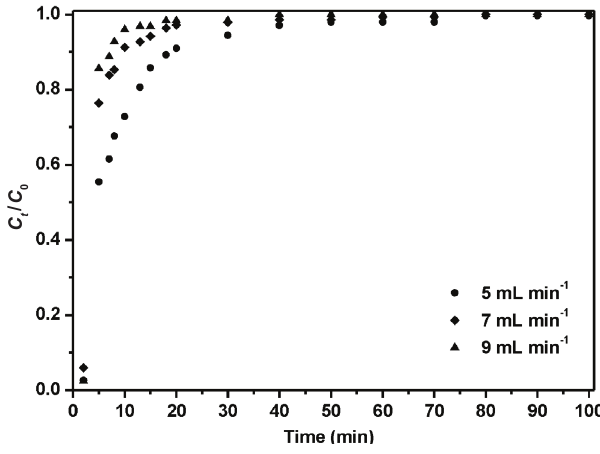
Fig. 3 – Effect of flowrate on breakthrough curves for ad- sorption of acrylic acid onto CaO